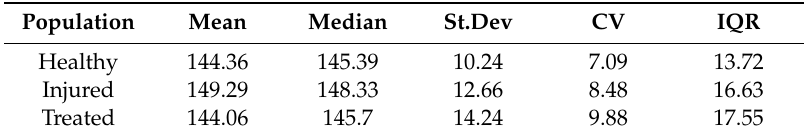
Figure 6. Boxplot representation of the brightness distribution among the corneal populations; a)